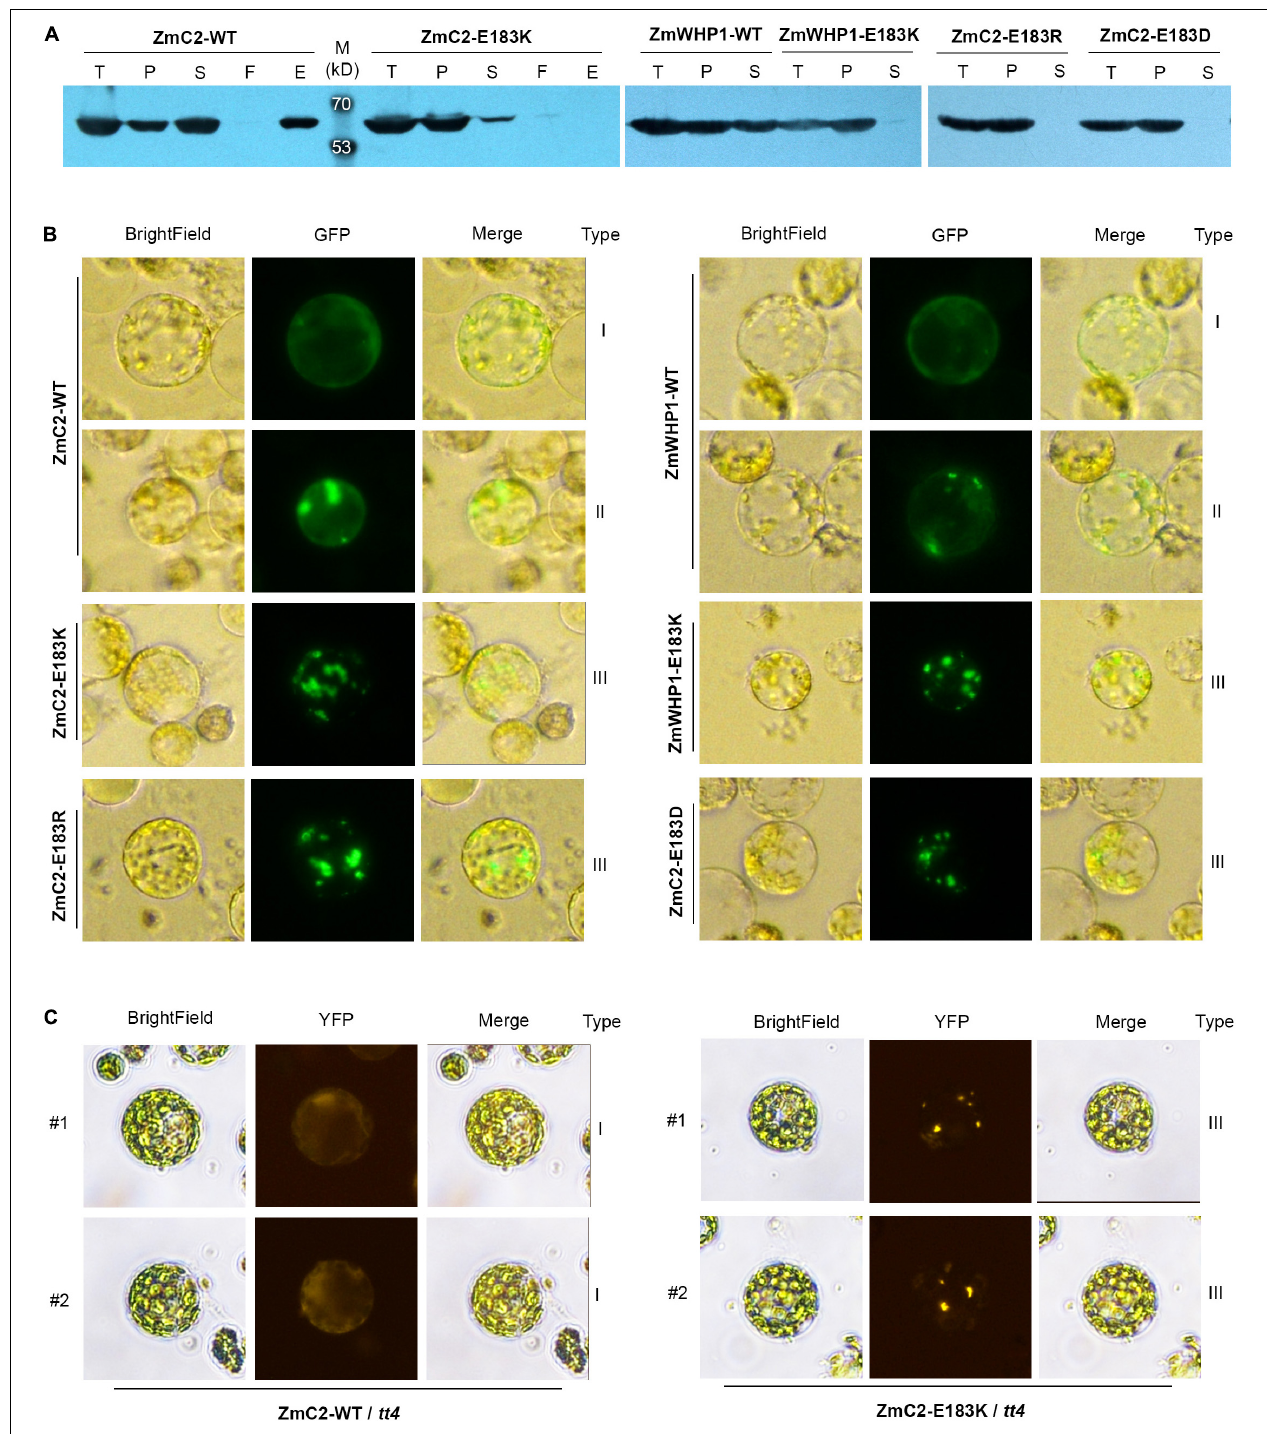
FIGURE 6 | Mutation on E183 causes protein aggregation of chalcone synthase (CHS). ZmC2/ZmWHP1-WT represents the wild-type chalcone synthase ZmC2/ZmWHP1; ZmC2/ZmWHP1-E183K/R/D represents ZmC2/WHP1 with E to K/R/D mutation at 183rd amino acid. (A) Western blot (anti-His-tag) after prokaryotic expression. 6xHis-tag was added at protein’s N terminal. Fused protein was purified using Ni-NTA column. T, E. coli cells after IPTG induction (total protein); P, precipitant of lysate of E. coli cells (precipitated protein); S, supernatant of lysate of E. coli cells (soluble protein); F, flow-through products from column; E, elution product from column (purified protein). (B) Transient expression of CHS in maize leaf protoplasts. GFP-tag was fused at protein’s C-terminal. (C) Stable expression of ZmC2 in leaf protoplasts of transgenic Arabidopsis. ZmC2-WT and ZmC2-E183K were fused with YFP-tag and transformed into Arabidopsis tt4 mutant. For each gene, two independent transgenic lines (#1 and #2) were